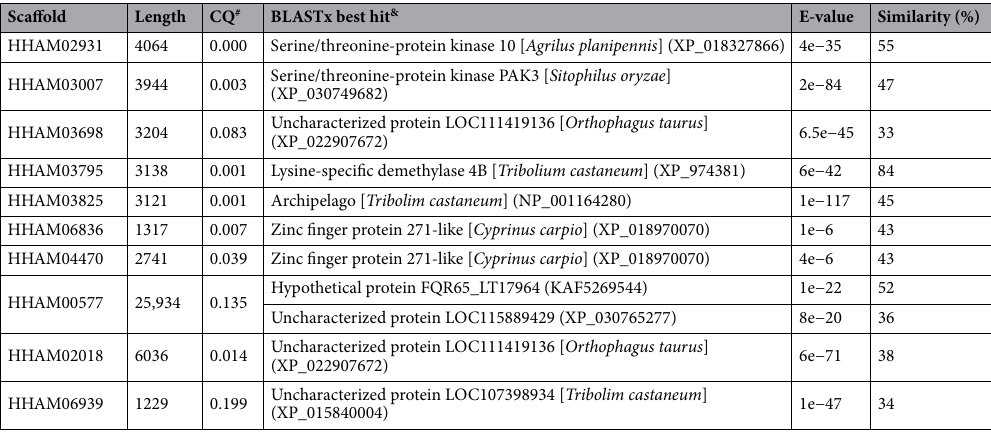
Table 2. Candidate Y-linked genome scaffolds with detected putative protein-coding sequences. # Chromosome Quotient (CQ). & BLASTx search against the NCBI reference protein